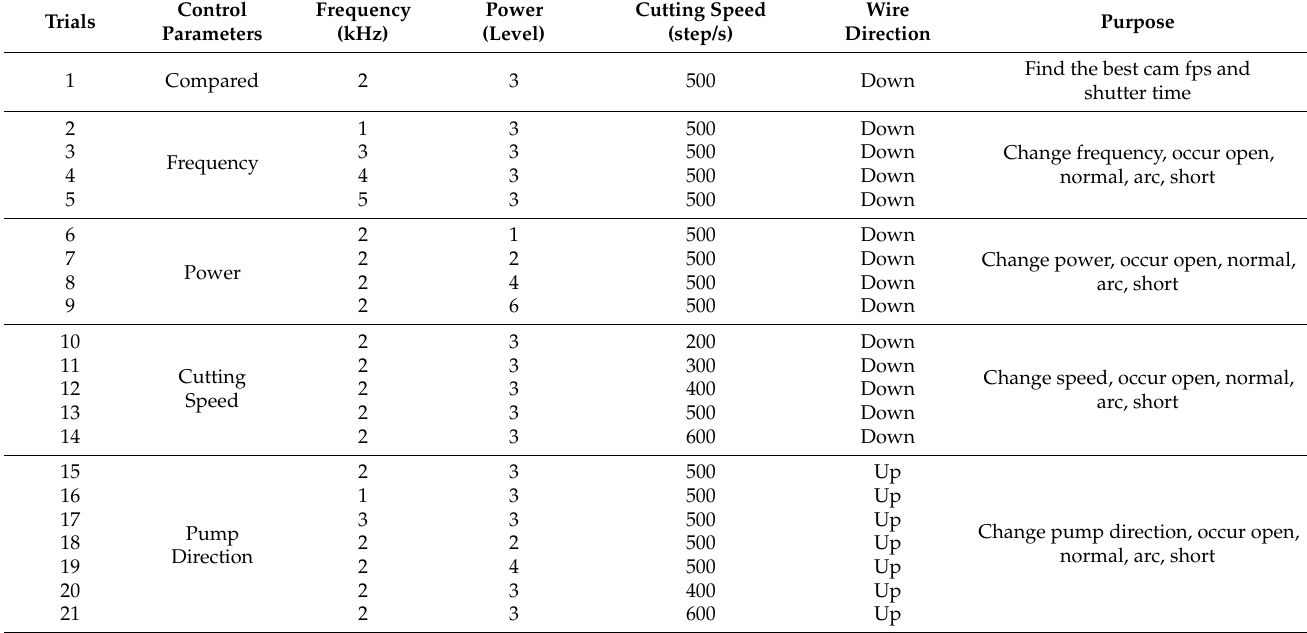
Table 3. Experiment